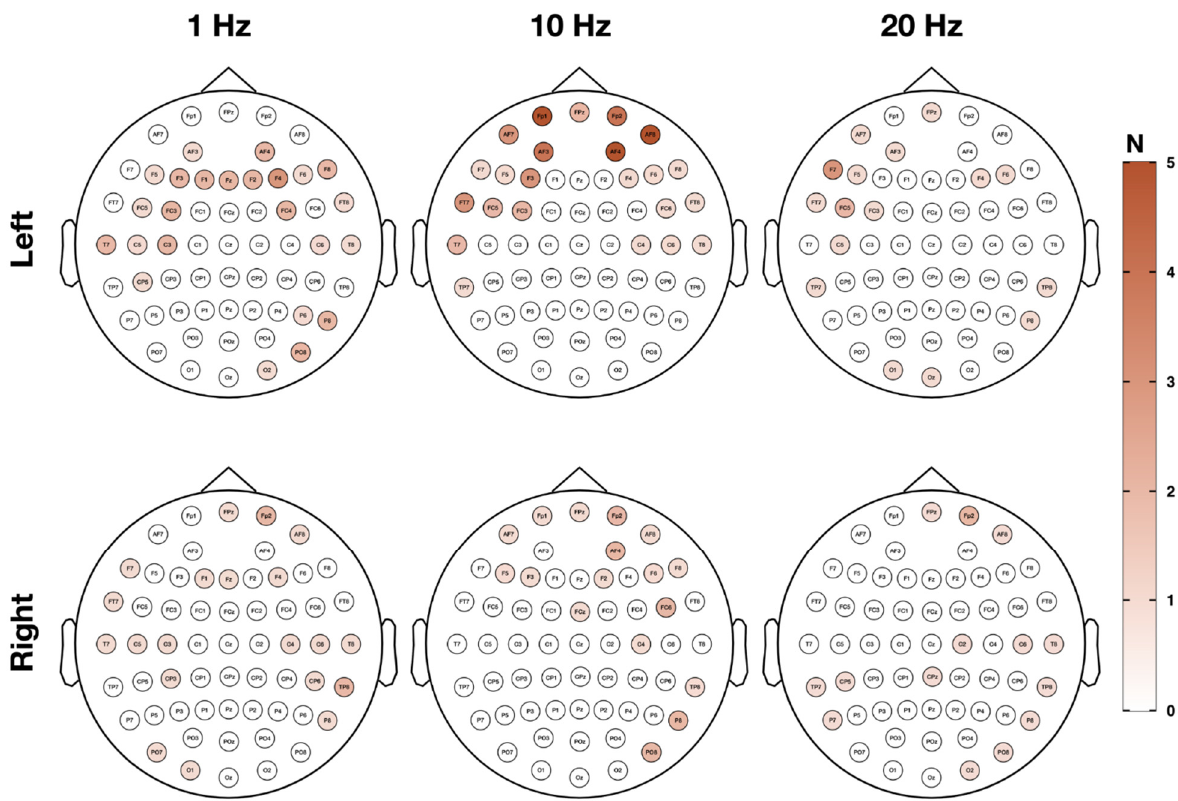
Figure 5. Topography of electrophysiological response—gamma responder. In Figure 5, topography and quantity of sensors showing sham-superior decreases in the gamma frequency band in a minimum number of two neighboring channels on both test session days are illustrated per rTMS protocol. Responses in the gamma frequency band (33–44 Hz) to one of the verum protocols mostly appeared over frontal electrodes on both hemispheres and partially over parieto-occipital sensors.